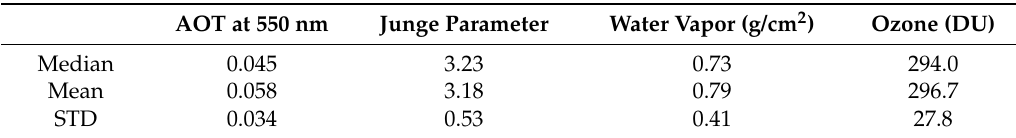
Table 1. Median, mean, and standard deviation (STD) of atmospheric parameters calculated using measurements from AERONET and TOMS/OMI for the Railroad Valley Playa. AOT at 550 nm Junge Parameter